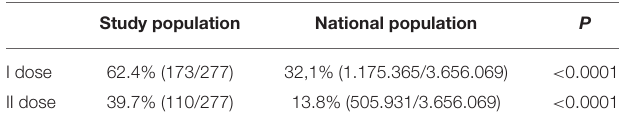
TABLE 2 | Differences in vaccine coverages between study cohort and national population. Study